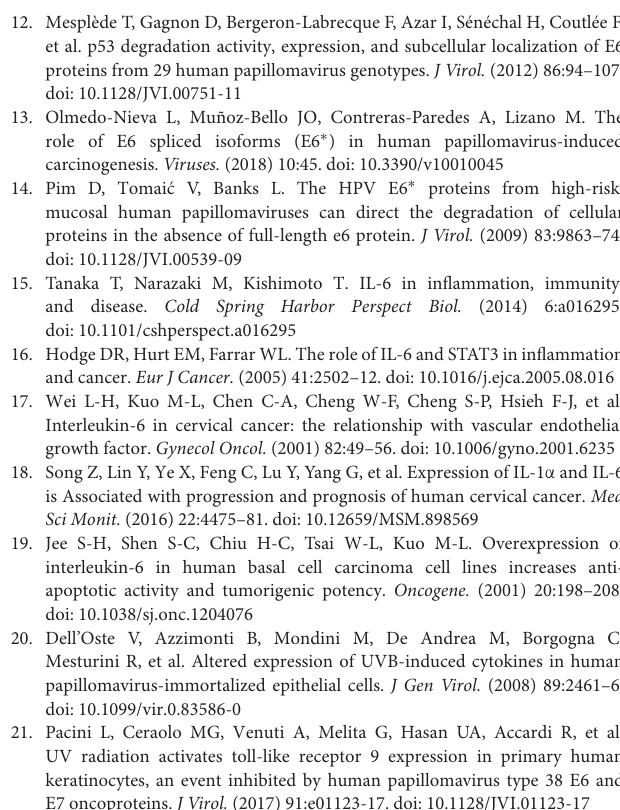
pcDNA3 vector. (B) IL-6 mRNA expression in the same cells transfected with pcDNA3-p53wt compared to cells transfected with pcDNA3 empty vector. Actin was used as reference gene and error bars represent standard deviation. Results from three independent experiments are shown in this Figure. pcDNA3 and pcDNA3-p53wt were transfected in the cells using X-tremeGENE HP DNA Transfection Reagent (06365752001, Roche) and RNA was extracted 24h